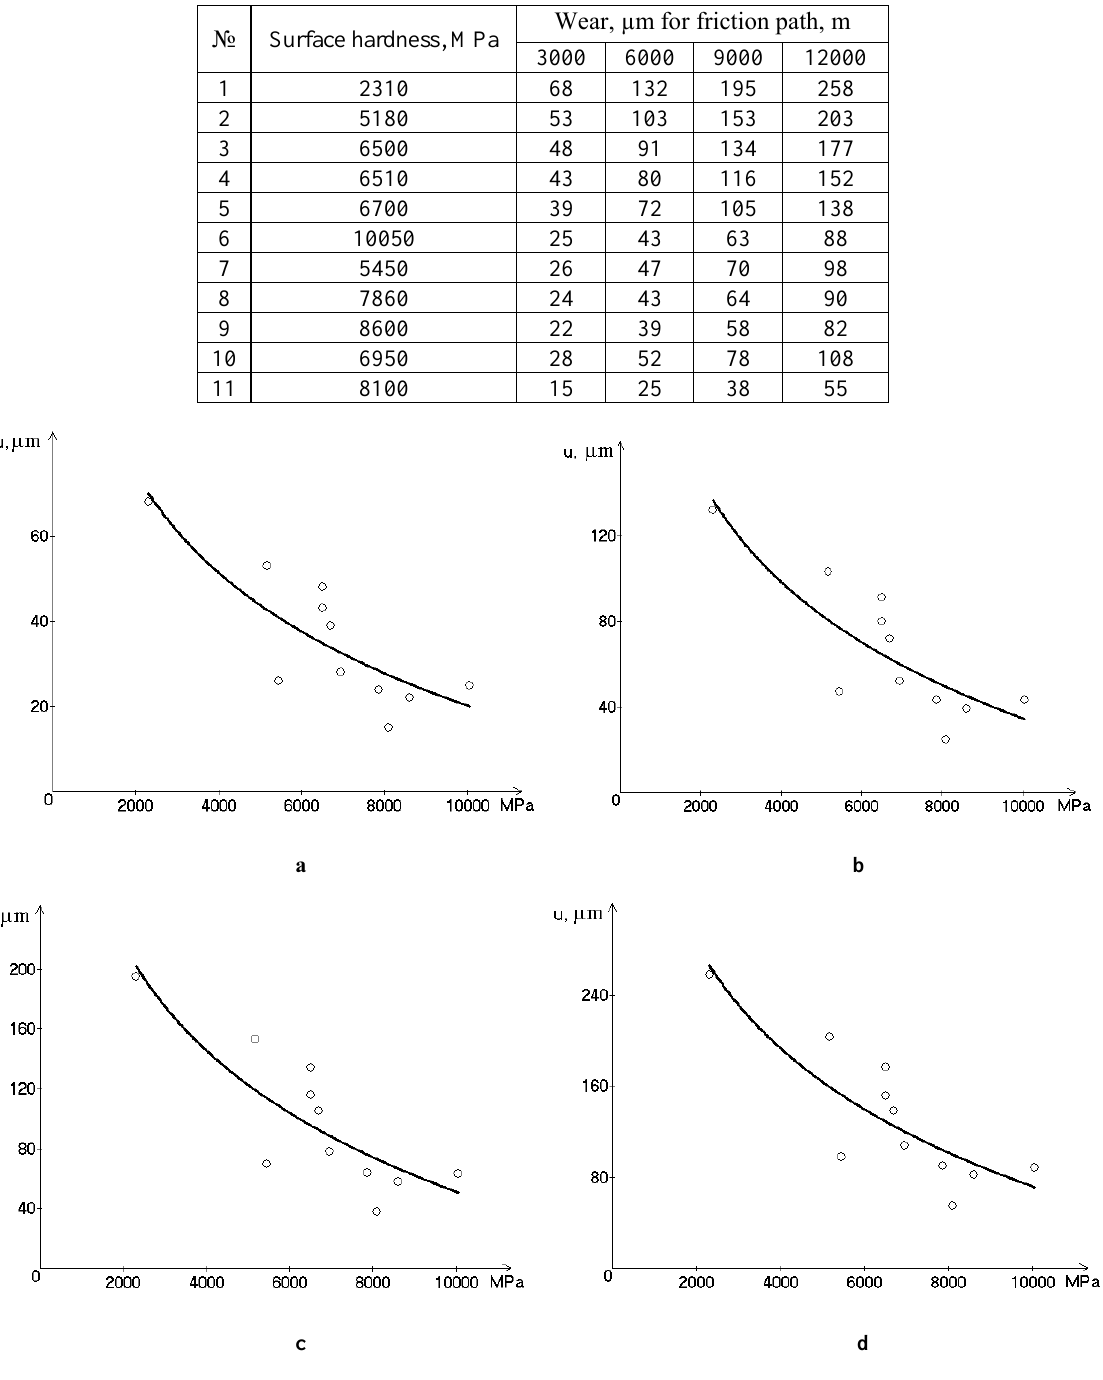
Fig.1. The wear of the auger depending on the hardness of its surface for different values of the friction path: а – s = 3000